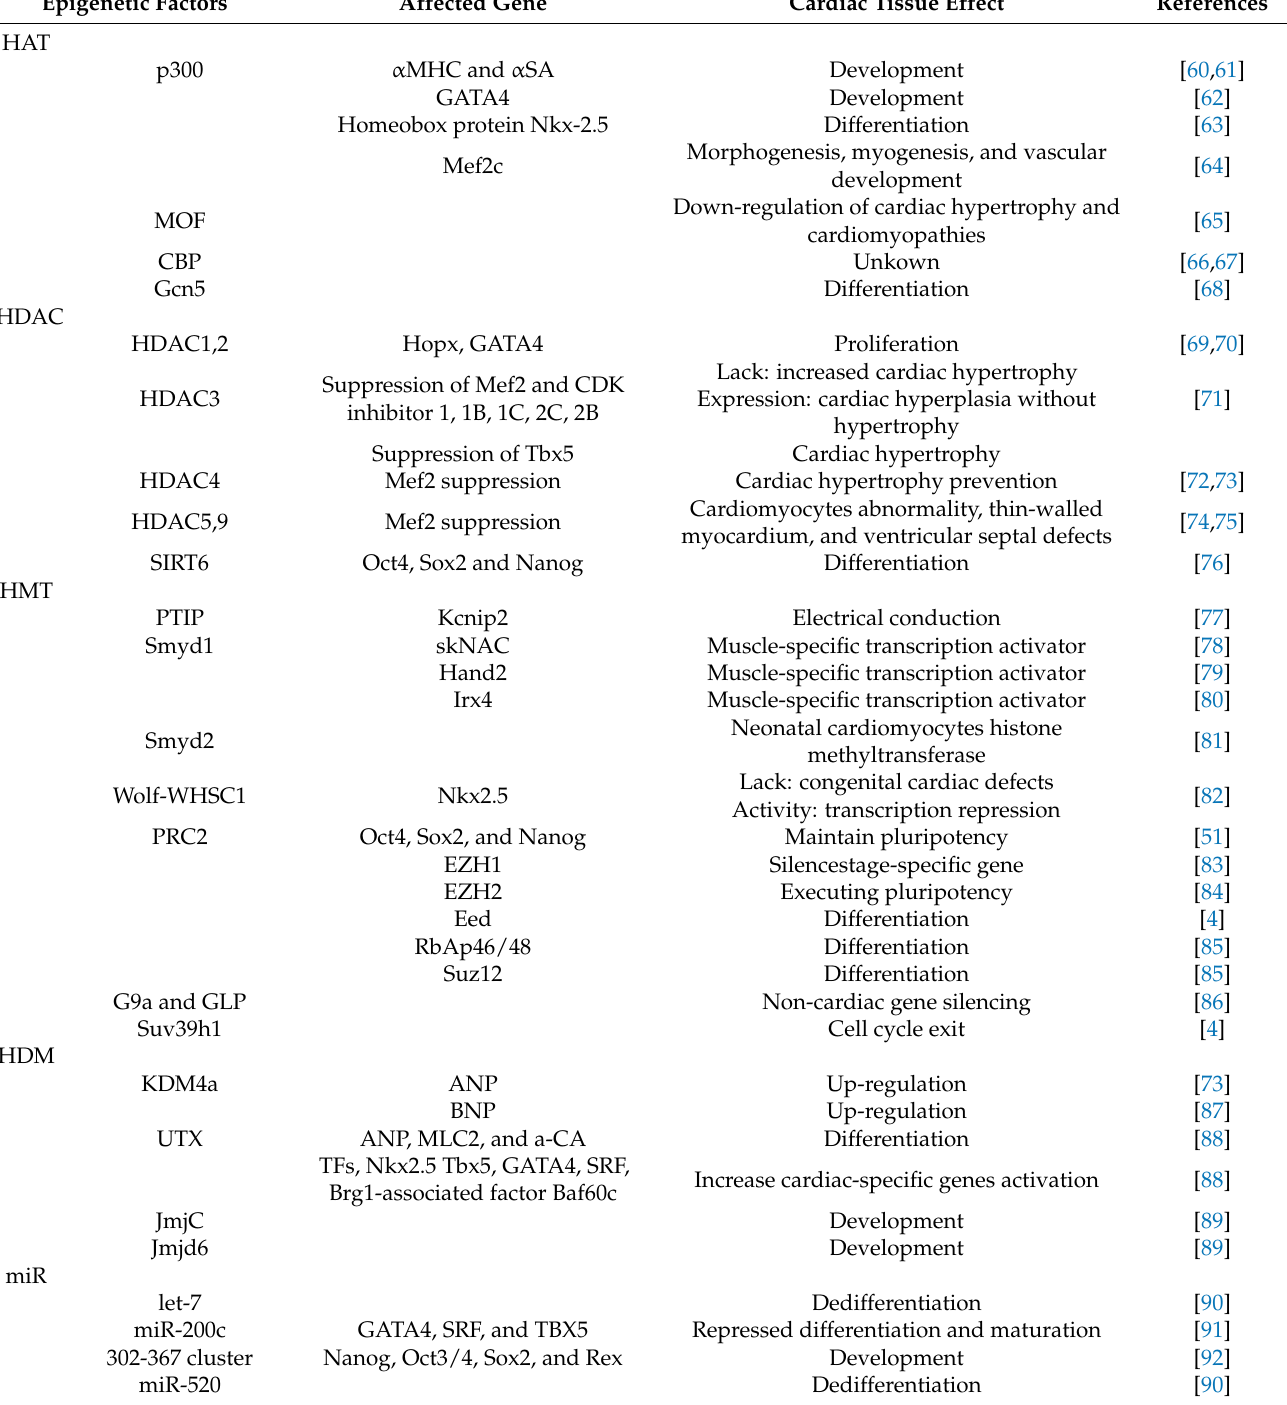
Table 2. Epigenetic histone markers in cardiac-specific gene